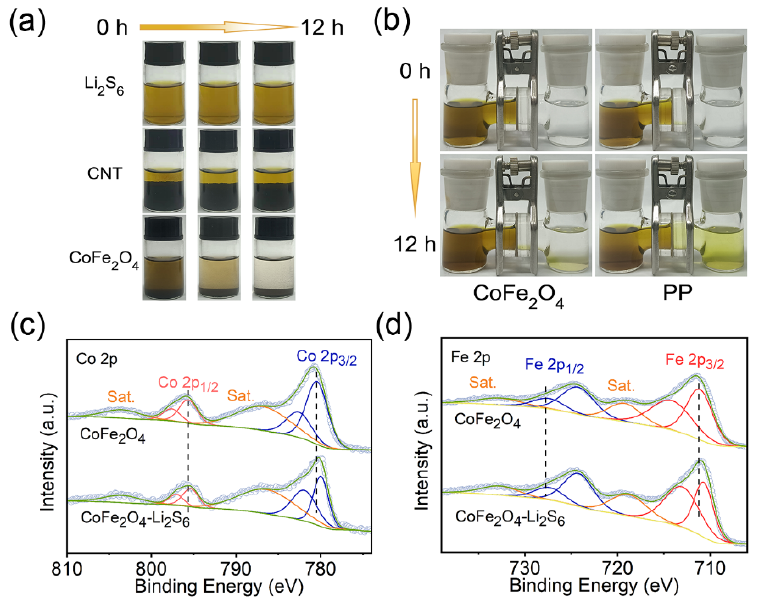
Figure 2. ( a ) Visual adsorption experiment; ( b ) lithium polysulfide penetration test; ( c ) Co 2p; and ( d ) Fe 2p XPS spectra of CoFe 2 O 4 sample before and after Li 2 S 6 adsorption. The curve of the grey circle connection is the data point of the original data, and the curve fitted by the XPS analysis software is green. The yellow line is the baseline. For Figure ( c ): the orange curve represents the peak of the metal cobalt salt, and the red and blue curves represent the peak position of the Co 2P orbital. For Figure ( d ): the orange curve represents the peak of the metallic iron salt, and the red and blue curves represent the peak position of the 2P orbit of